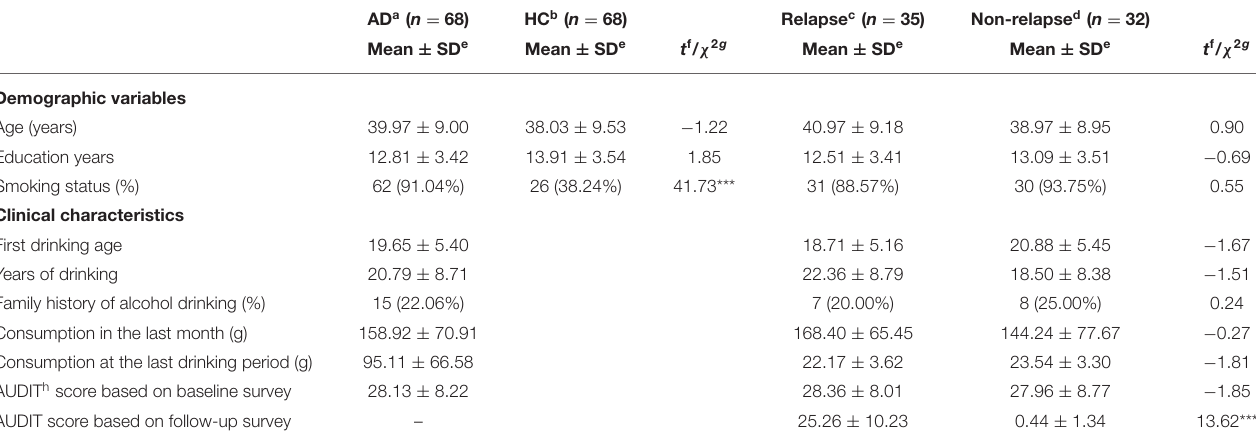
TABLE 1 | Sample demographics and their clinical characteristics based on baseline- and follow-up